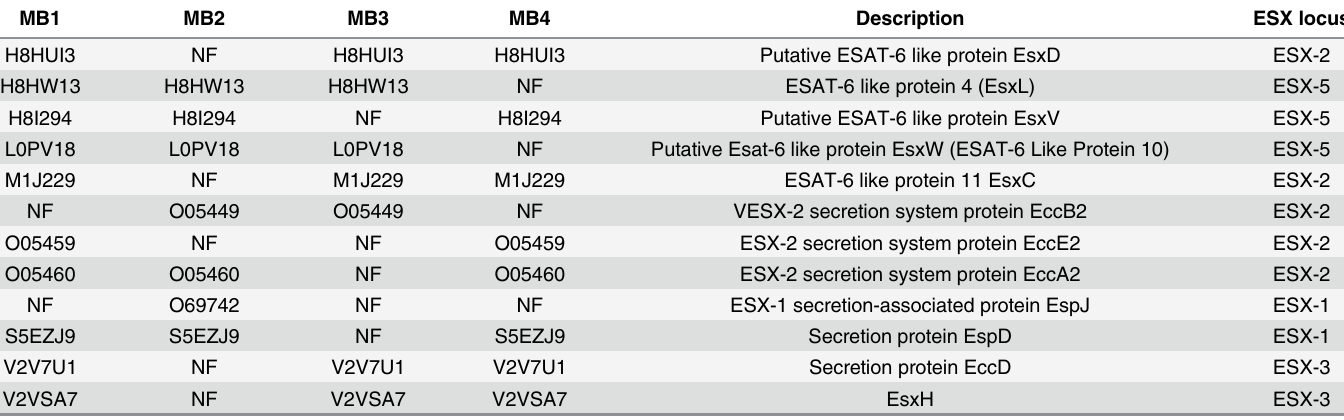
Table 2. Differentially represented ESX-coding